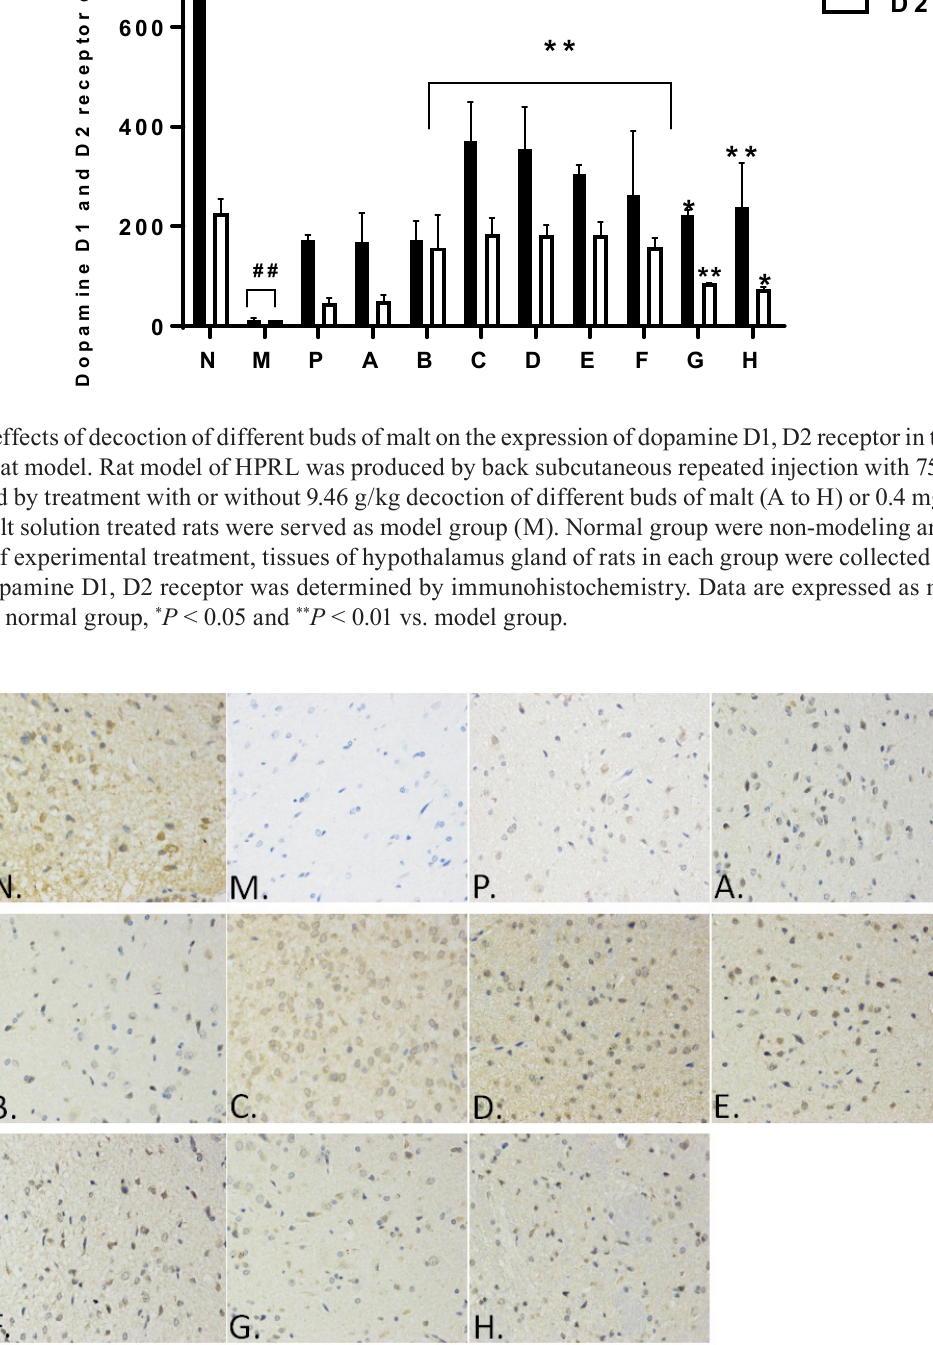
FIGURE 8 – Dopamine D1 receptor expression in the hypothalamus was observed by microscope (original magnification, 400×). The positive reaction of dopamine D1 receptor in the hypothalamus was brown in cytoplasm, and the darker the color was, the greater its positive expression was (N) normal controls; (M) model group; (P) bromocriptine group; (A) 0.25 cm bud of malt group; (B) 0.50 cm bud of malt group; (C) 0.75 cm bud of malt group; (D) 1.00 cm bud of malt group; (E) 1.25 cm bud of malt group; (F) 1.50 cm bud of malt group; (G) 1.75 cm bud of malt group; (H) 2.00 cm bud of malt